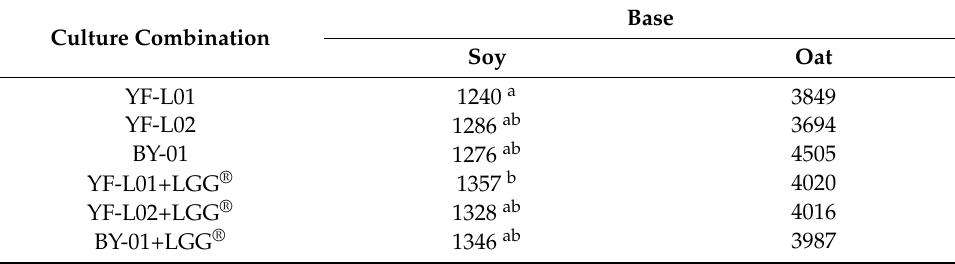
Table 5. Hysteresis loop area of fermented soy and oat